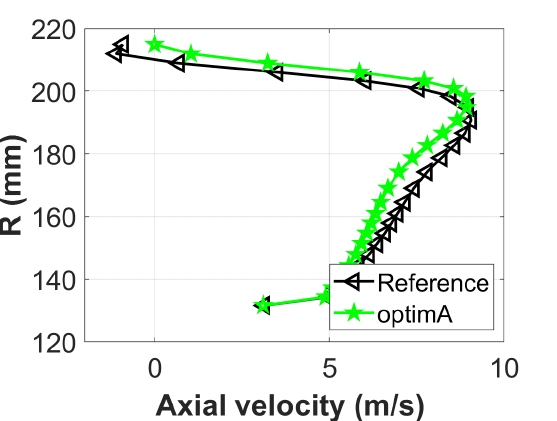
Figure 9. Axial velocity at the downstream of the fan